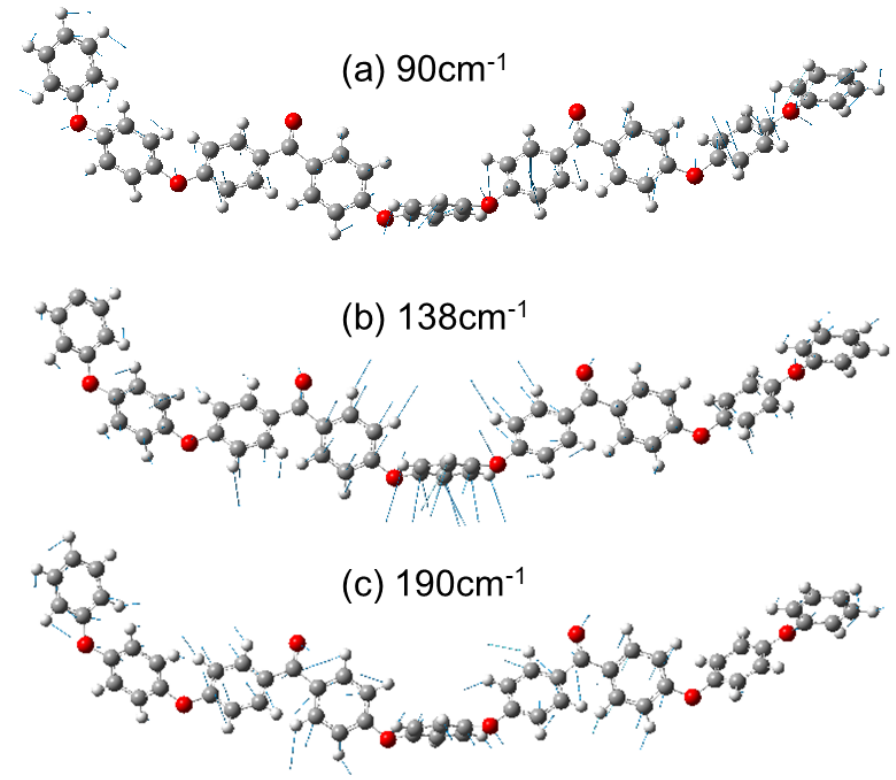
Figure 4. Atomic motion in the vibrational modes at ( a ) 90 cm − 1 , ( b ) 138 cm − 1 and ( c ) 190 cm − 1 , calculated for a single oligomer molecule by DFT.